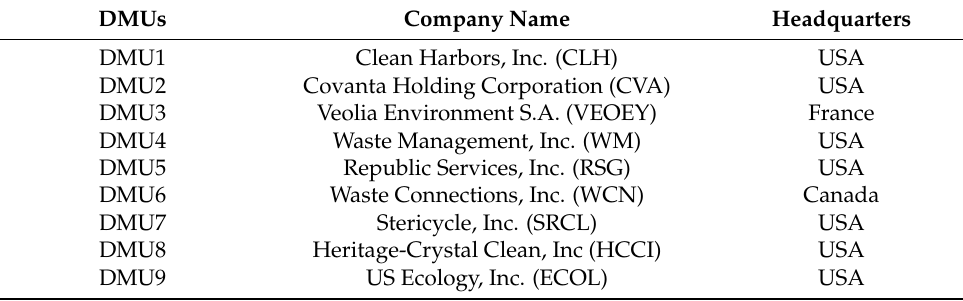
Table 1. List of waste management